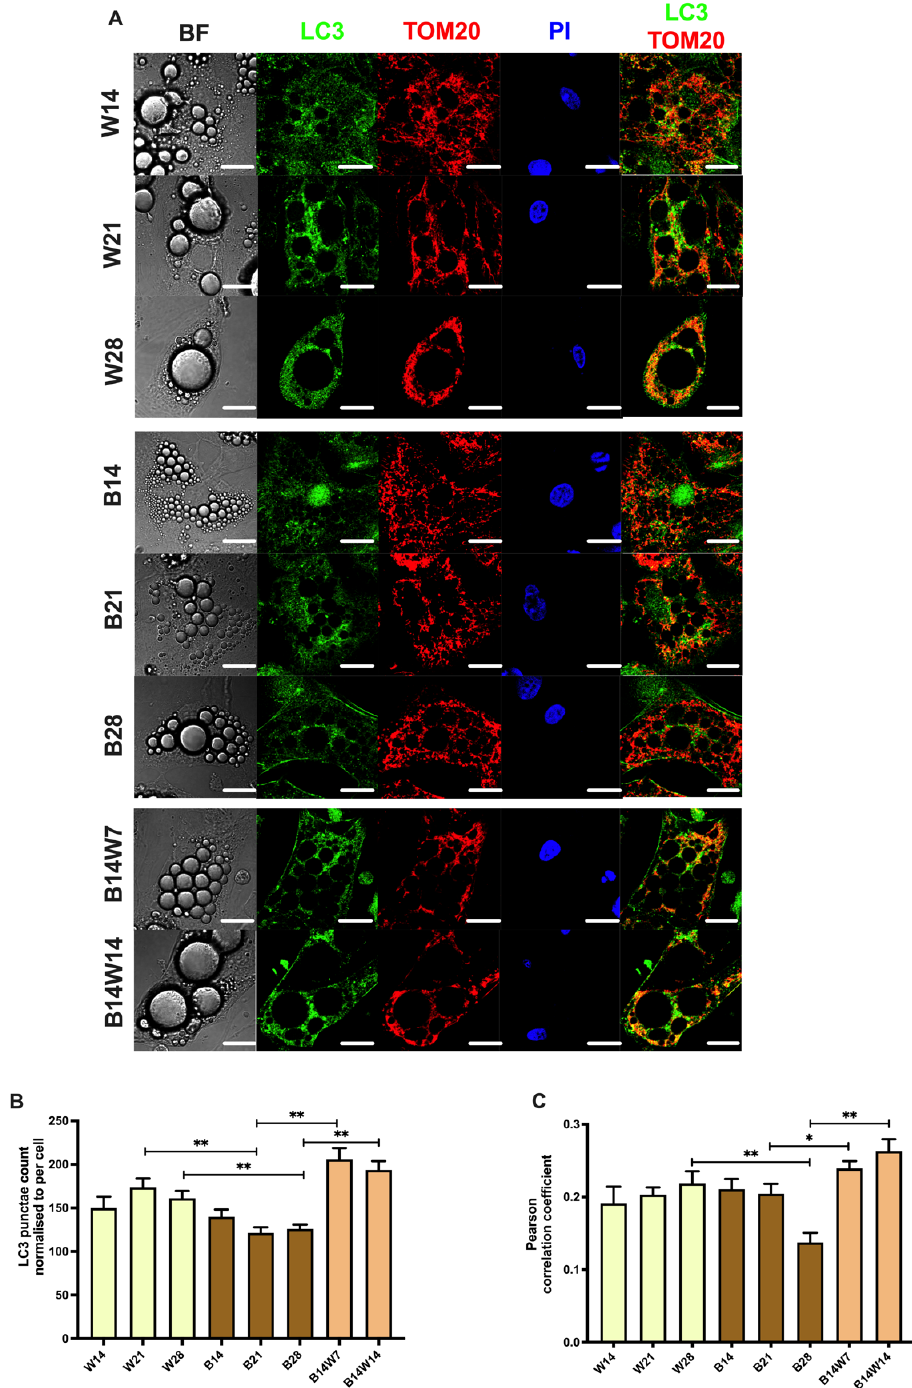
Figure 5. Mitophagy was repressed following long-term rosiglitazone treatment and increased upon beige (B) to white (W) transition. Human primary abdominal subcutaneous preadipocytes were differentiated, as in Figures 1–4. ( A ) Representative confocal microscopy images of LC3 and TOM20 immunostaining; nuclei are labeled with propidium iodide (PI), and BF represents brightfield image; scalebars represent 10 μ m. ( B ) Quantification of LC3 punctae normalized to per cell ( n = 50 cells from three donors), ( C ) Quantification of mitophagy as co-localization of LC3 and TOM20 immunostaining ( n = 50 cells from three donors). Data are presented as mean ± SD. * p < 0.05, ** p < 0.01. We used one-way ANOVA with Tukey’s post hoc